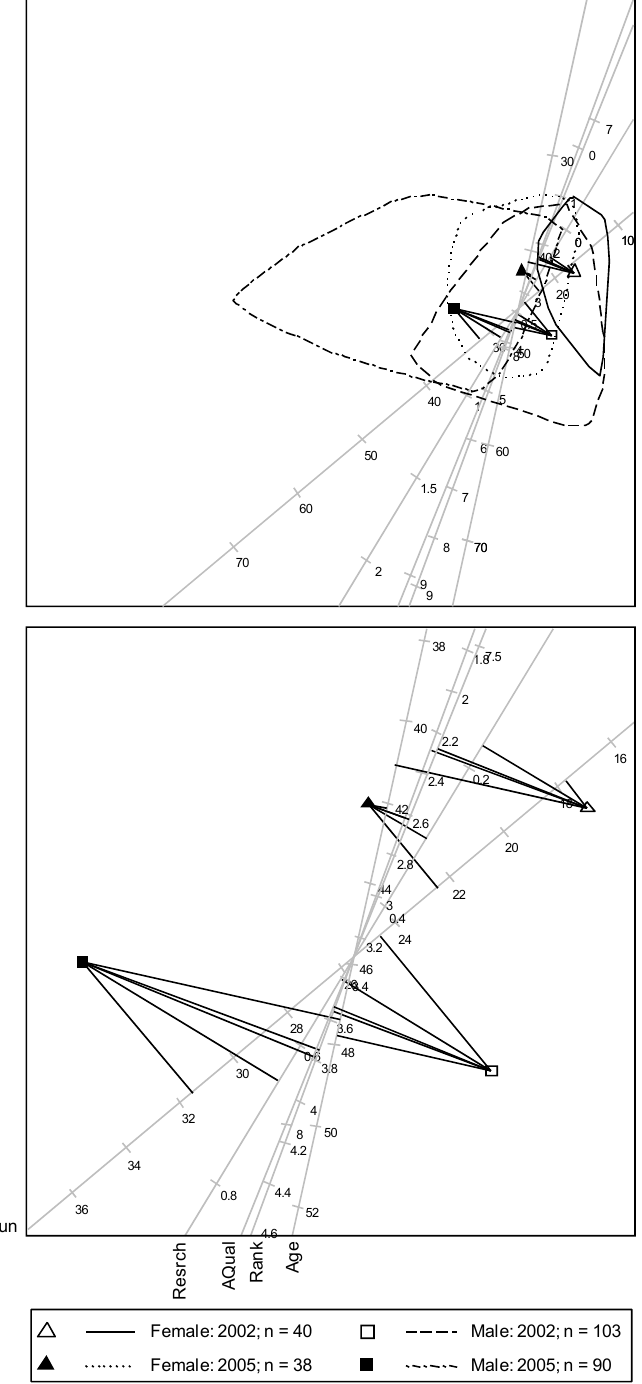
Figure 5: CVA biplot separating C1 staff in the Faculty of Science according to the 2002 Female, 2005 Female, 2002 Male and 2005 Male subgroups. Plotting of data points is suppressed. The upper panel shows the biplot overlaid with 90% bags. The bottom panel shows the group means on a large scale together with perpendicular lines from each group mean to the five axes for determining the biplot predictions of the different